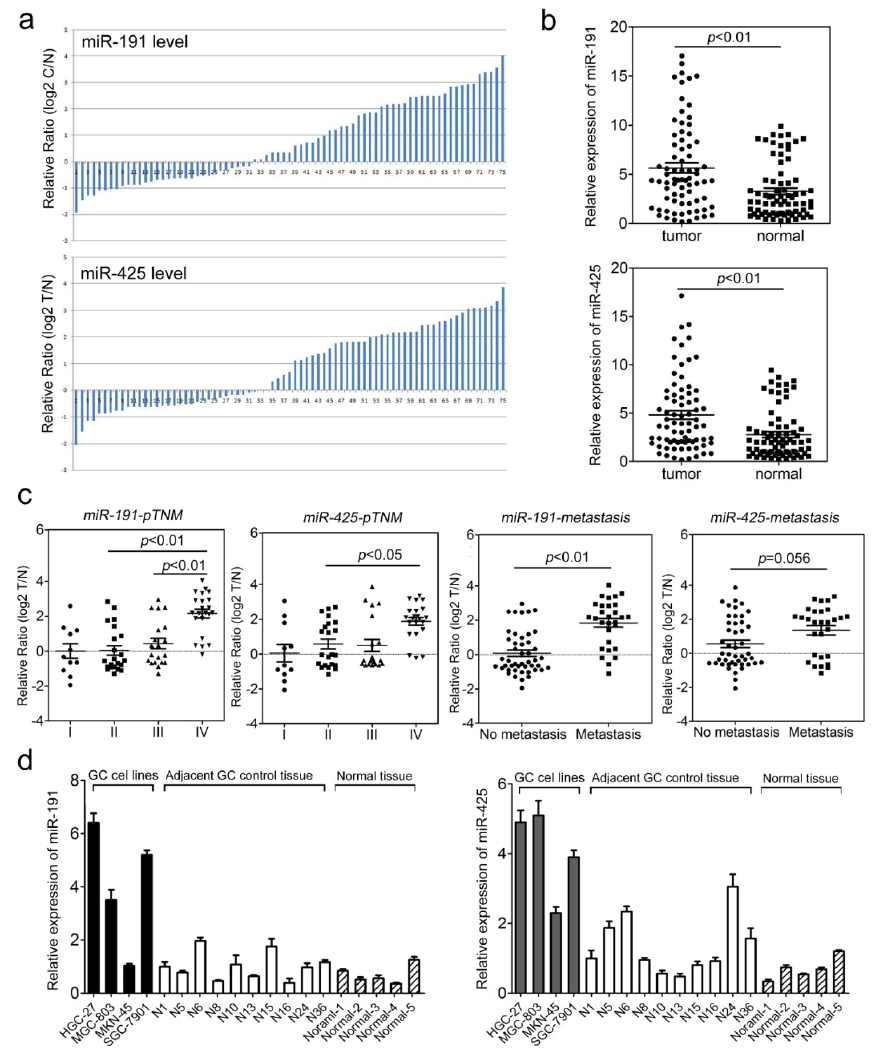
Figure 1. Expression of miR-191 and miR-425 in gastric cancer (GC) tissues and cell lines. ( a ) miR-191 and miR-425 were detected in 75 GC tissue samples with the adjacent normal controls by quantitative RT-PCR. Data are presented as log2 of fold change of GC tissues relative to adjacent normal regions; ( b ) Relative miR-191 and miR-425 expression levels in GC tissues and adjacent normal regions; ( c ) Statistical analysis of the association between miRNA levels and the pTNM stage (I, II, III and IV) and pM stage (No metastasis and Metastasis). Analysis of variance (ANOVA) was used to determine whether there were any significant differences between groups; ( d ) Relative levels of miR-191 and miR-425 in GC cell lines (HGC-27, MGC-803, MKN-45 and SGC-7901) relative to 10 GC adjacent normal control samples (Adjacent GC control tissue) and five normal gastric tissue biopsies from healthy people (Normal